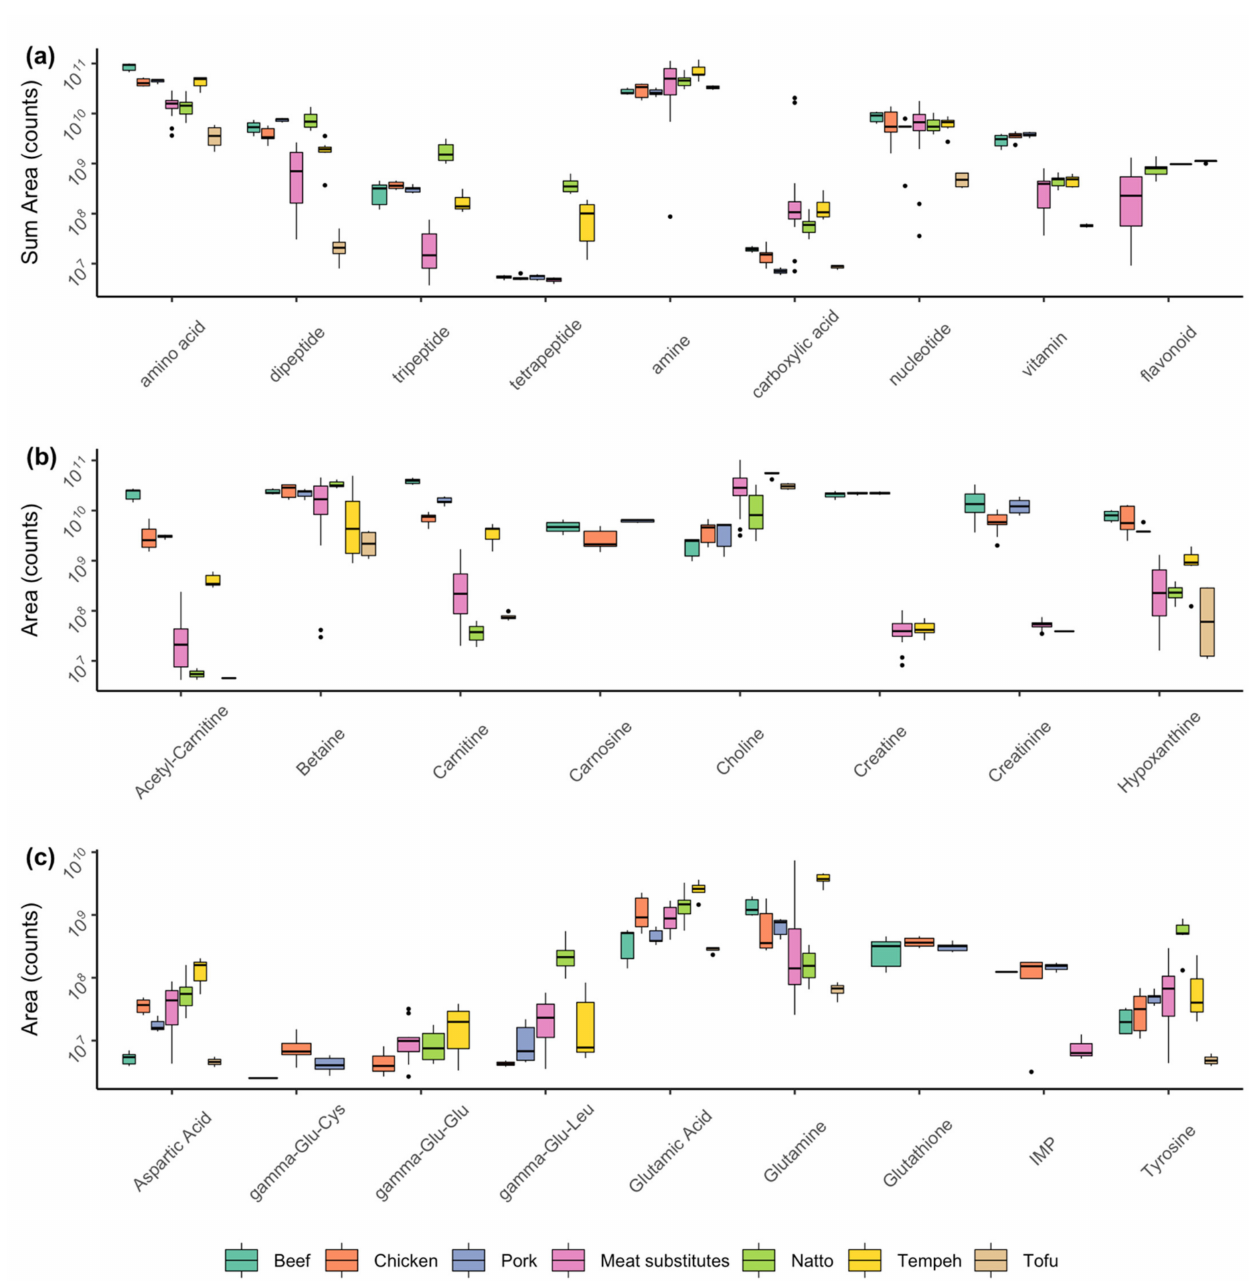
Figure 2. Non-volatile profile of meat, meat substitutes, natto, tempeh, and tofu. Box plots of: ( a ) All compounds from the major compound classes were summed, each sample was classified as either beef (green), chicken (orange), pork (blue), meat substitute (pink), natto (light green), tempeh (yellow), or tofu (beige); ( b ) the dominant amines in each sample group; ( c ) the dominant amino acids, di-, and tri-peptides; IMP is inosine 5 (cid:48) -monophosphate. Box plots show the median, 1st and 3rd quartiles, minimum and maximum values and the dots represent the